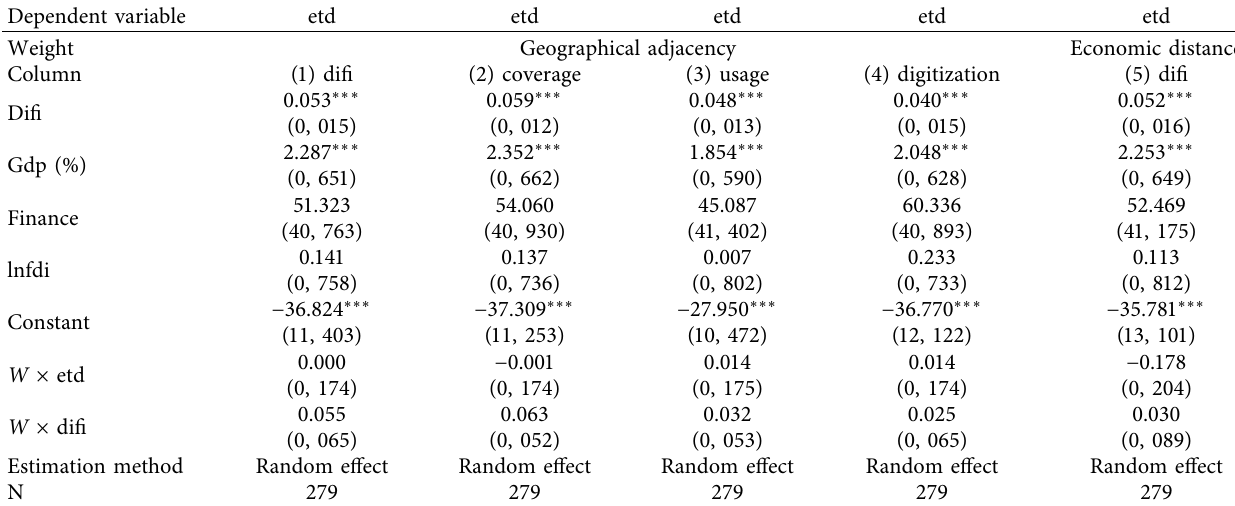
Table 5: Digital financial inclusion’s spatial effects on capital’s diversion from the fictitious to the substantial economy.